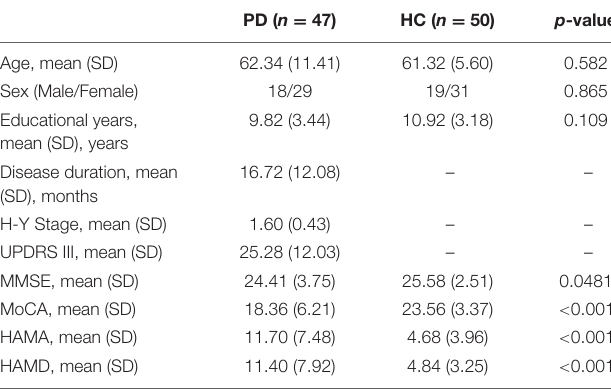
TABLE 1 | Demographic and clinical characteristics of PD and HC